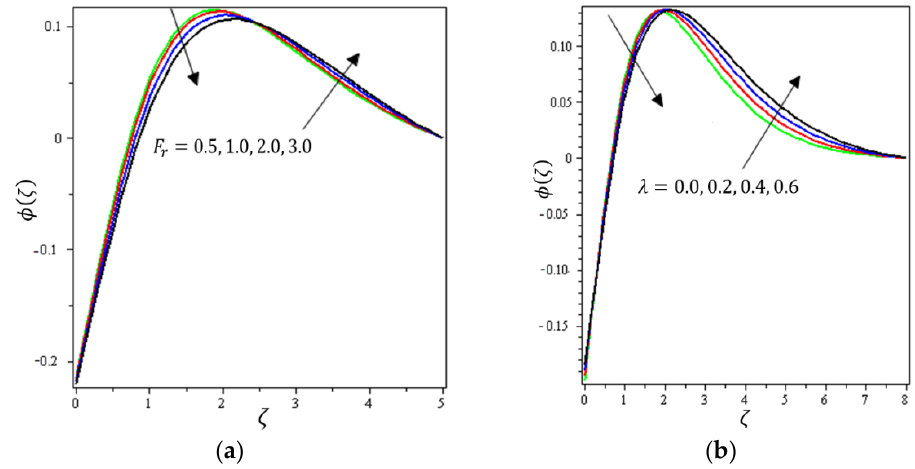
Figure 10. Influence of ( a ) Darcy–Forchheimer F r and ( b ) permeability parameter λ on φ ( ζ )